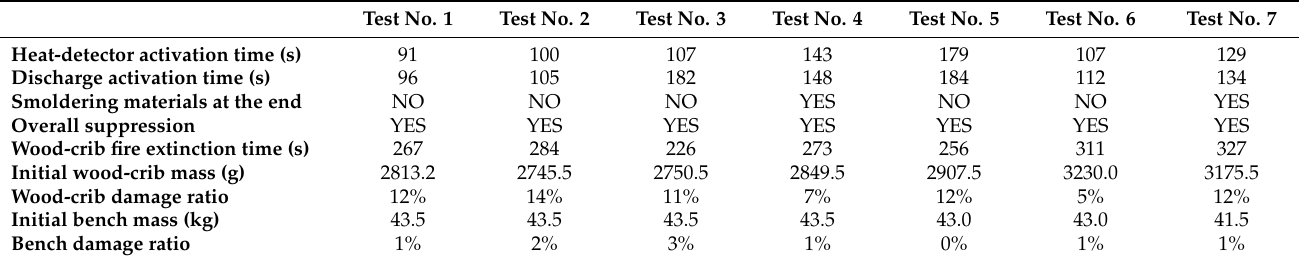
Table 3. Summary of the experimental